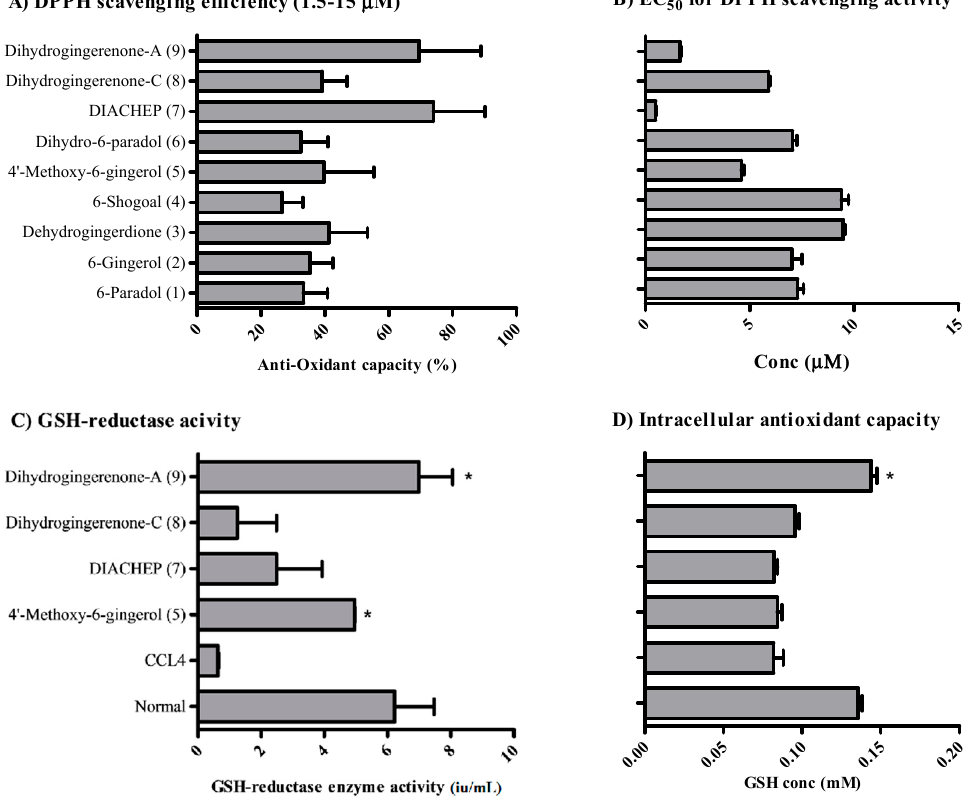
Figure 2. Antioxidant activity of isolated hydroxyphenylalkanes and diarylheptanoids was tested using a cell free system and with HepG 2 cells. Antioxidant capacities of the test compounds were tested using the DPPH free radical scavenging assay; scavenging efficiency ( A ) and EC 50 s ( B ) were calculated over concentration range of 0.5 to 50 µM. GSH reductase enzyme activity ( C ) and GSH concentration ( D ) were determined in CCl 4 challenged HepG 2 cells. Data is presented as mean ± SD; n = 3. *: significantly different from CCl 4 treated group.